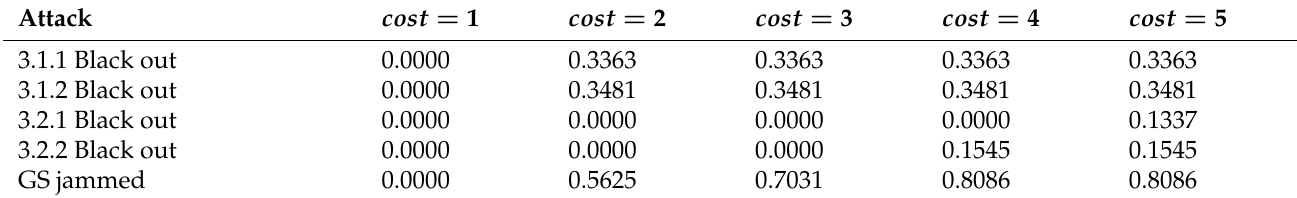
Figure 12. Smart grid and black-out attack use case results. Table 16. Smart grid and black-out attack use case risk exposure